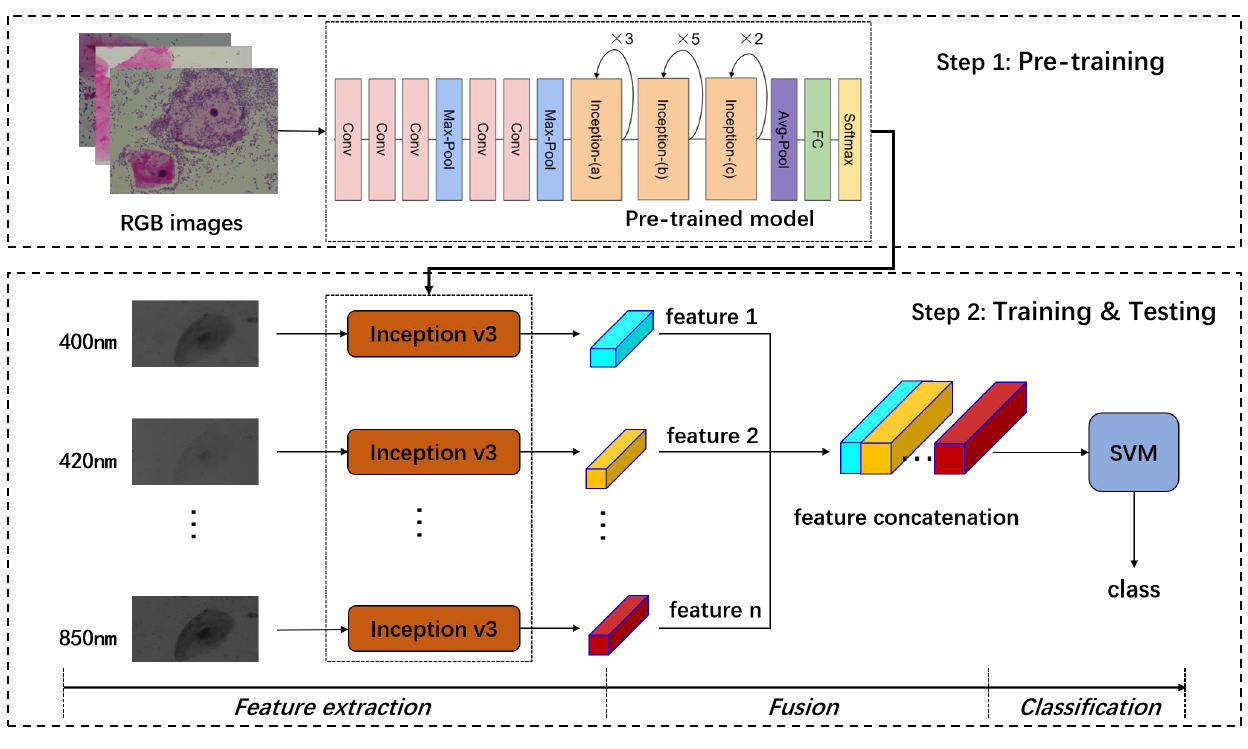
Figure 2. The block diagram of